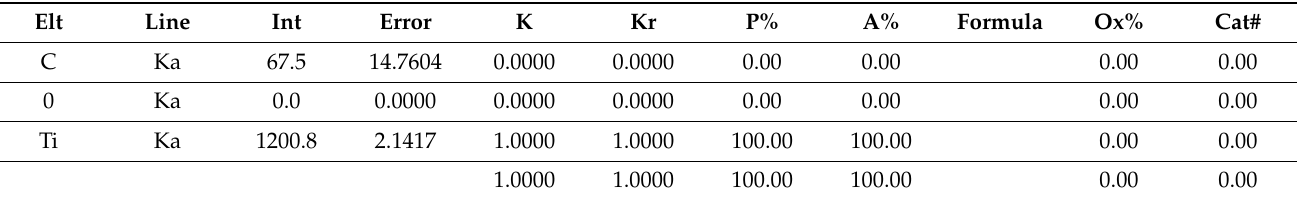
Table 4. The quantitative results of the EDS analysis of the Straumann implant demonstrating weight percentages (P%) and atomic percentages (A%) of the elements detected